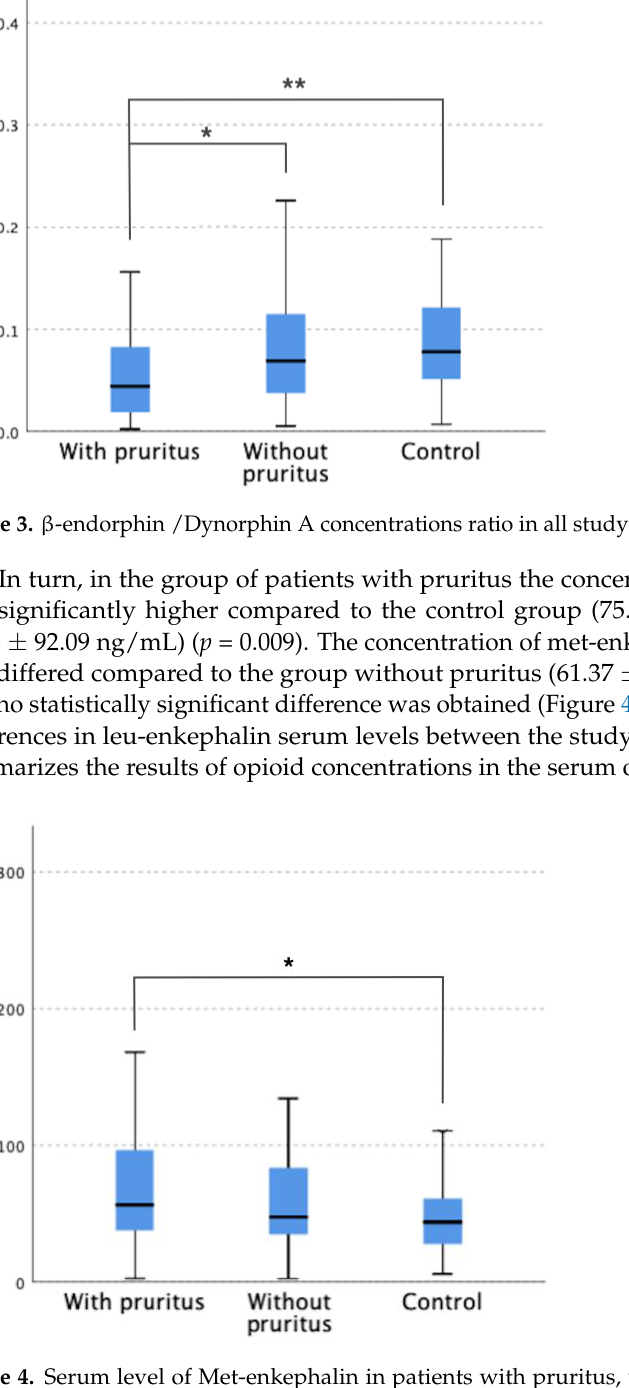
Figure 2. Serum level of Dynorphin A in patients with pruritus, without pruritus, and control group. ** p < 0.001.